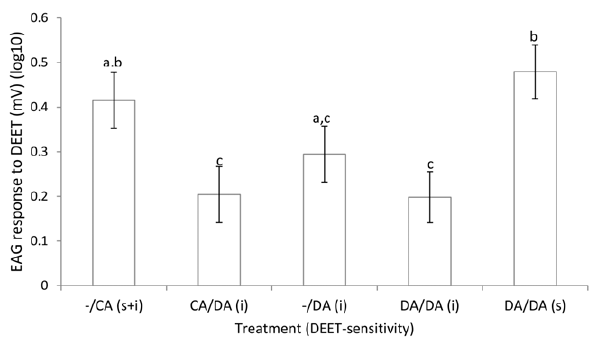
Figure 2. Olfactory responses of DEET-sensitive and insensitive mosquitoes. EAG responses of female Aedes aegypti showing behavioural DEET-sensitivity (s) or DEET-insensitivity (i) in experiment 1. Mosquitoes of unknown DEET-sensitivity (s + i) were collected from cages tested with a control arm. DEET-insensitive females were collected from cages tested with DEET on an arm (DA), tested first with a control arm and then DEET on an arm (CA/DA), and tested with DEET on an arm then retested with DEET on an arm (DA/DA). DEET- sensitive mosquitoes were also collected from cages tested with DEET on an arm and then retested with DEET on an arm (DA/DA). Means are 6 SEM. Means with different letters are significantly different from each other (p ,